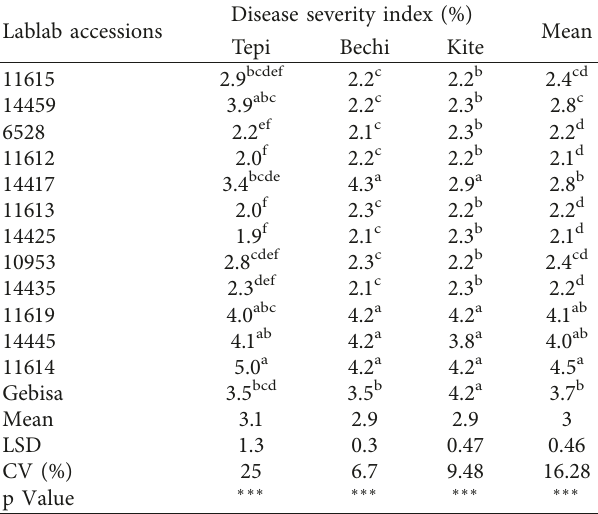
Table 10: Mean squares of agronomic traits from combined analysis of variance for lablab purpureus varieties at Tepi, Bechi, and Kite locations